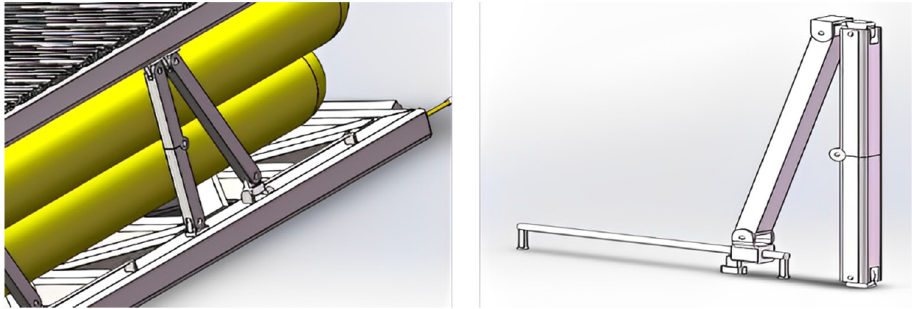
Figure 3. The vertical connection of the floating